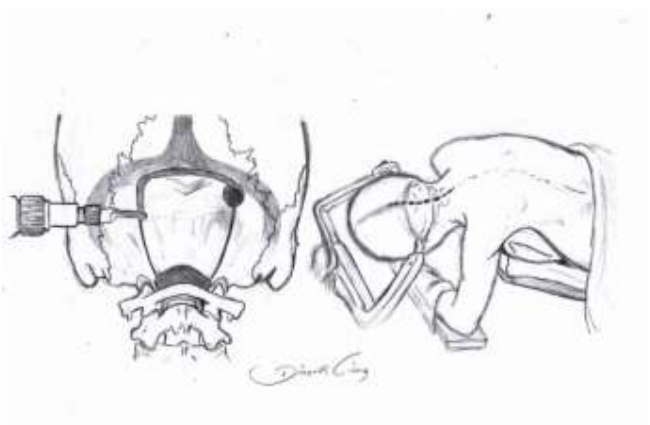
Figure 3. A midline craniotomy can be performed to approach the pineal lesions. A suboccipital approach is sufficient for localized lesion. extending to the pineal region, venous sinuses or supratentorial space. The torcula and transverse sinus may be exposed and a supracerebellar–infratentorial or supracerebellar– transtentorial approach can be implemented.